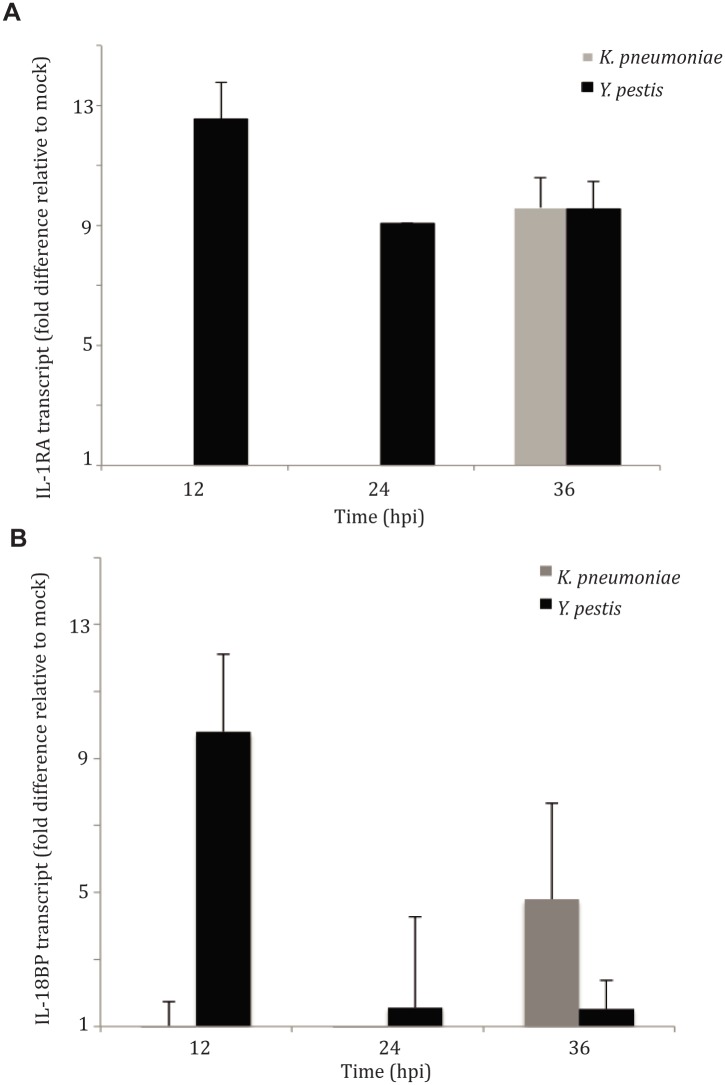
IL-1RA is induced in the lung early during pulmonary infection with Y. pestis, but not K. pneumoniae.Real time qRT-PCR analysis for (A) IL-1RA and (B) IL-18BP activation from lungs of mice inoculated with either an LD100 dose of Y. pestis (1x104 CFU) or K. pneumoniae (2x105 CFU), at 12, 24 and 36 hpi (N = 3, per experiment). Fold difference calculated as ΔΔ Ct.